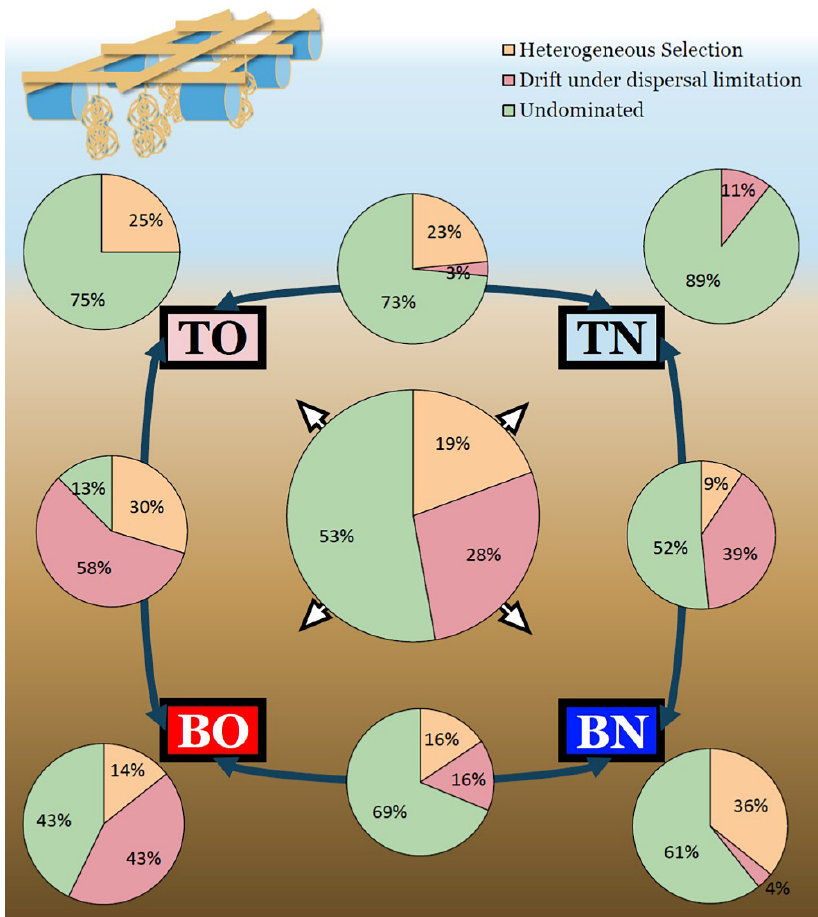
Figure 5. ( A ) Phylogenetic β -diversity based on keystone species only shown by NMDS; ( B ) key- stone species based on phylogenetic β -diversity in the PCoA. Each point represents one sample.